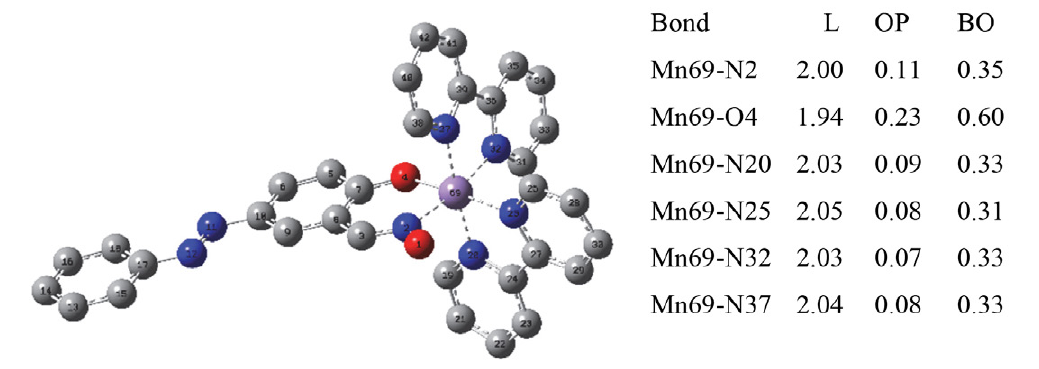
Figure 3: Optimized molecular structure of complex 1 and selected bond length in Å (L), overlap population (OP) and bond order (BO).